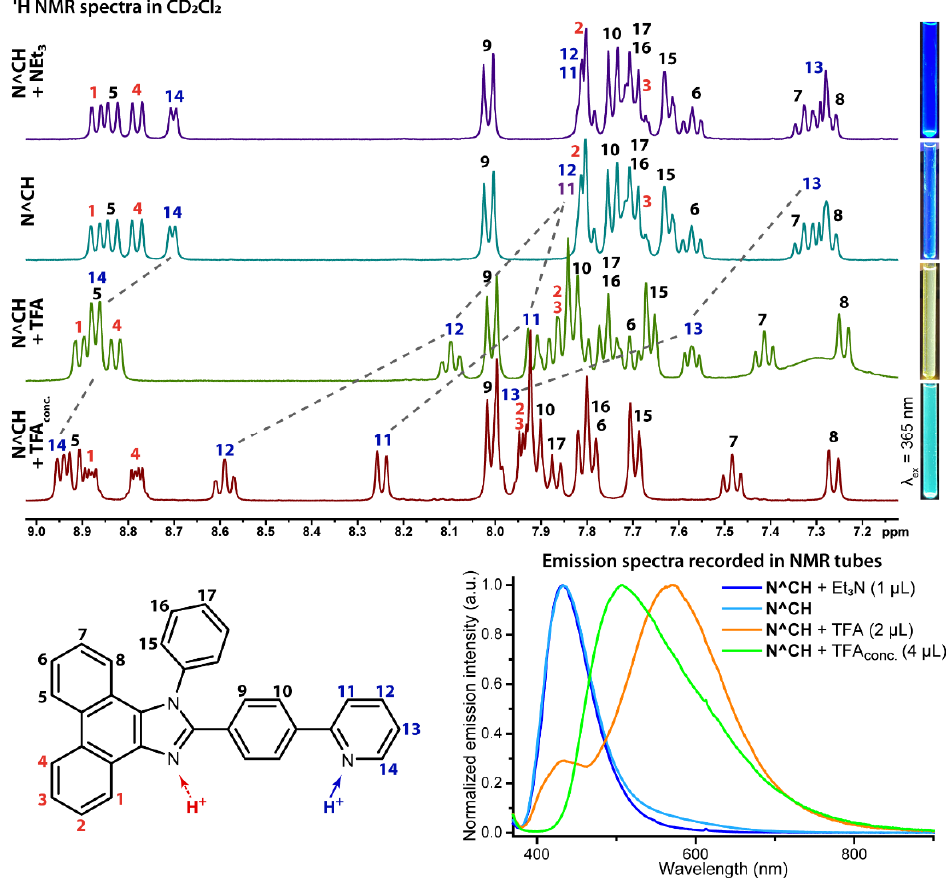
Figure 4. 1 H NMR spectra of N^CH upon addition of TFA. Bottom: N^CH emission spectra recorded in NMR tubes, λ ex = 365 nm.